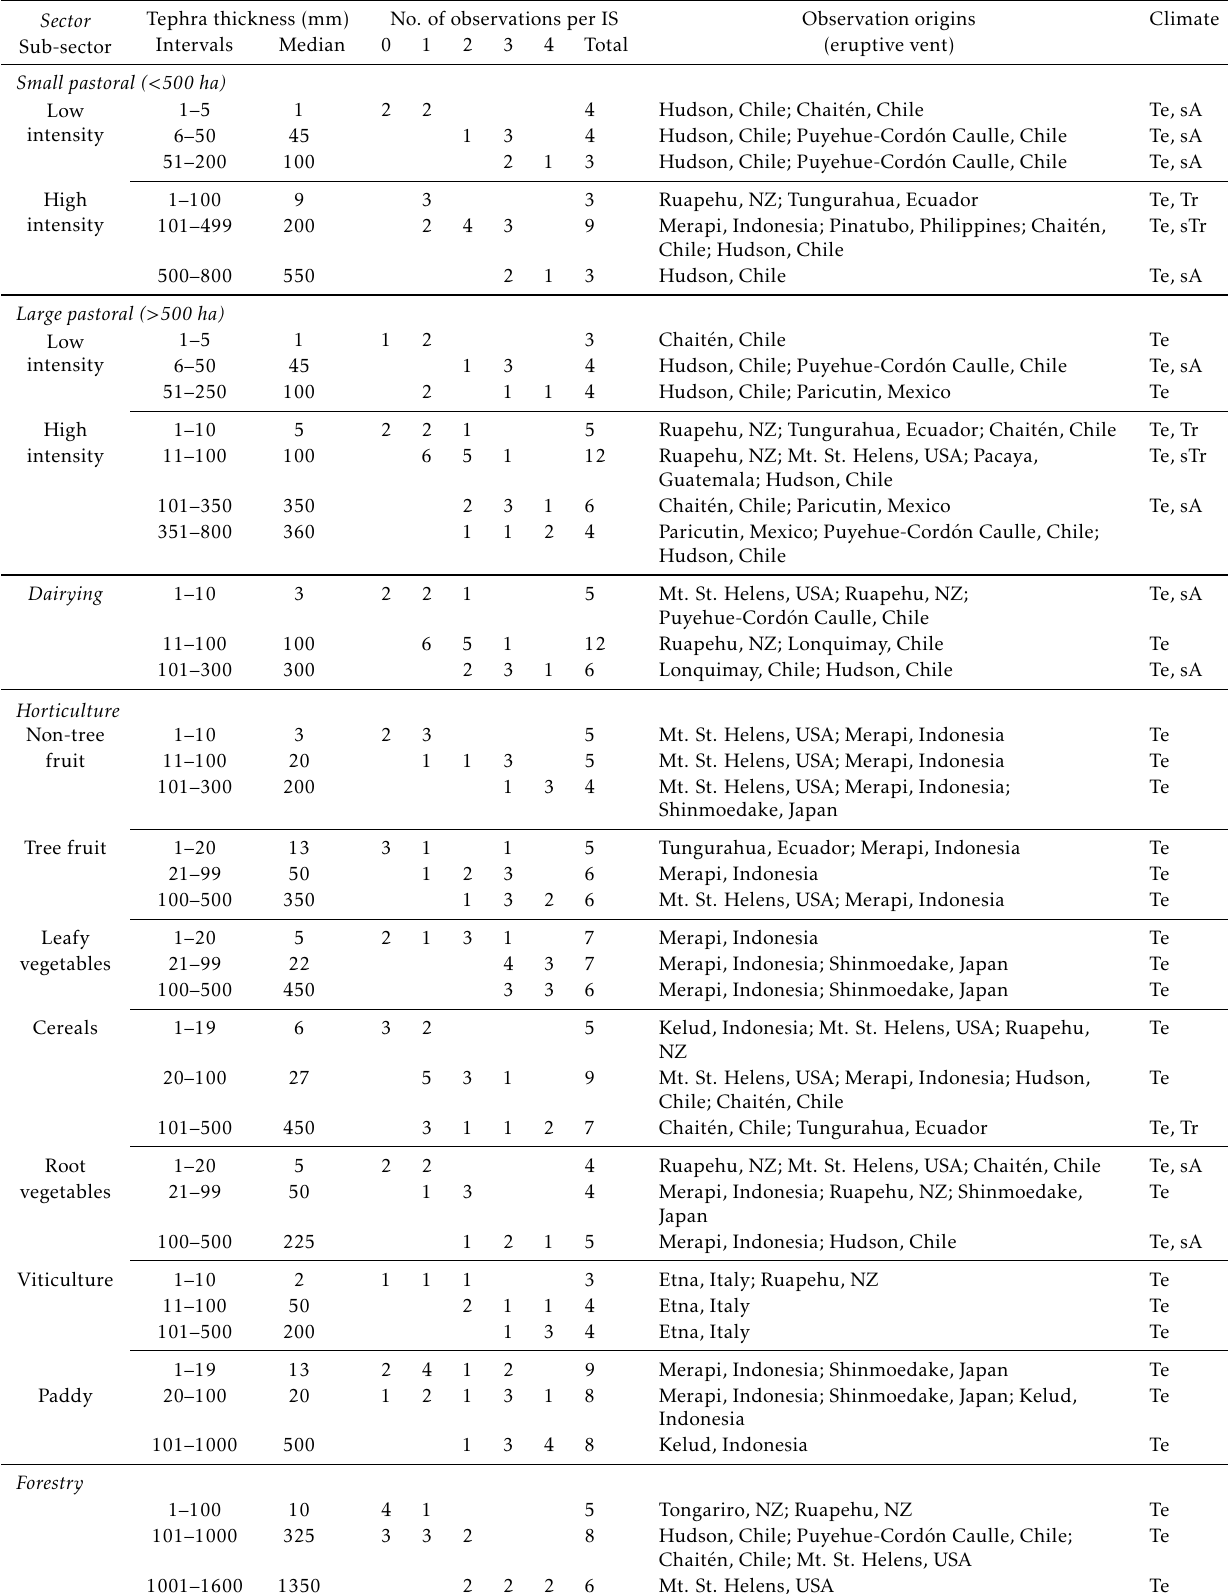
Table 1: Summary of the compacted tephra thickness bands used and the number of observed points within each band. Te = Temperate, Tr = Tropical, sTr = sub-tropical, sA = semi=arid.